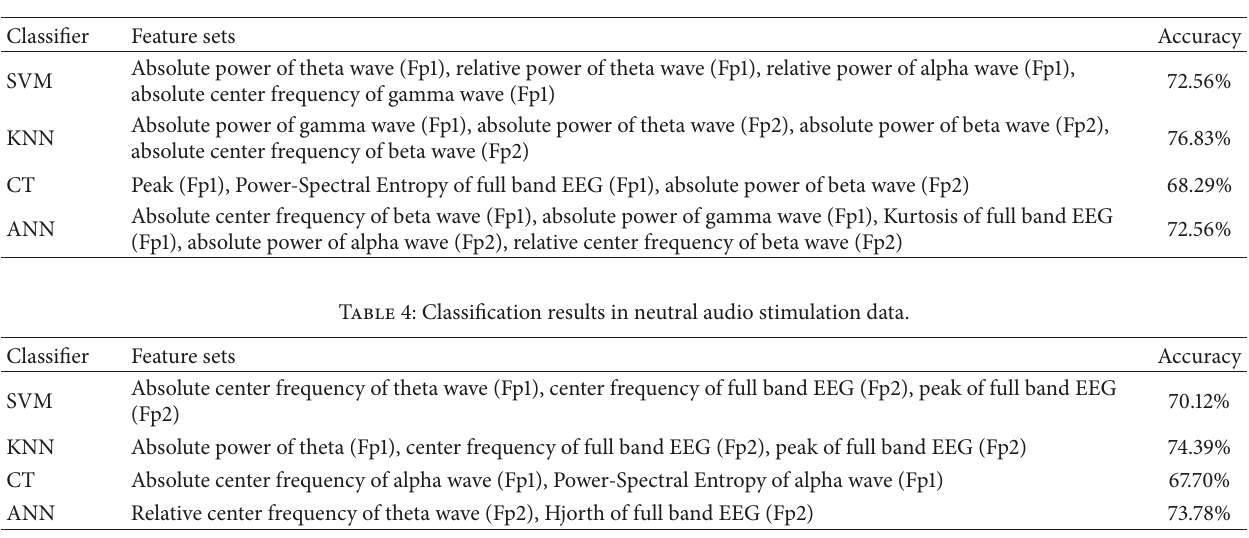
Table 3: Classification results in resting state data.